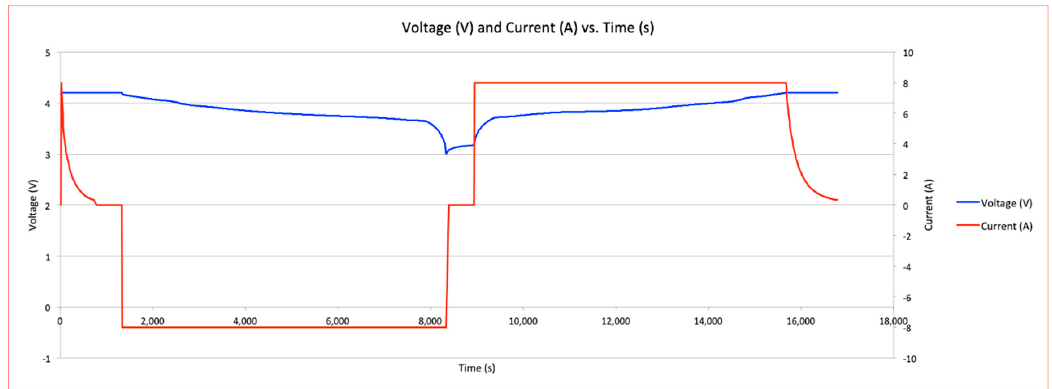
Figure 15. Battery individual cell testing: Voltage and current vs. time.